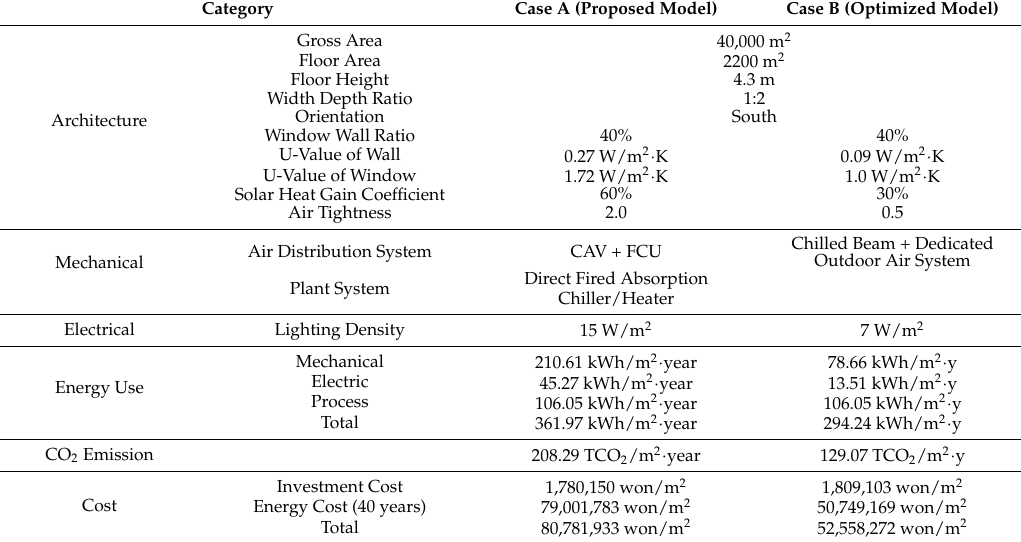
Table 11. Evaluation